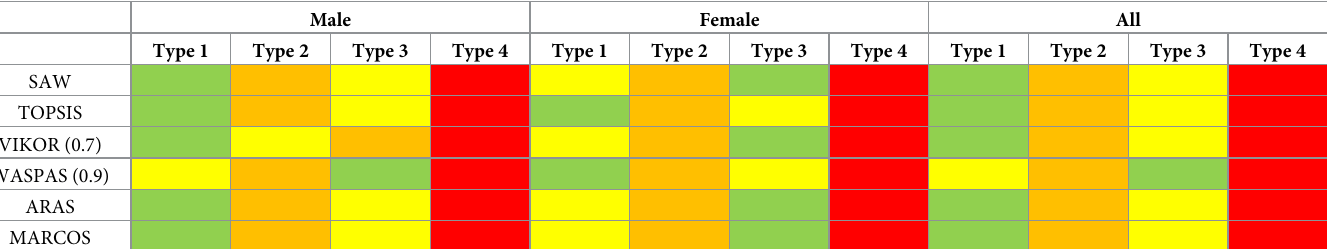
Table 6. Results of six MCDM compensatory